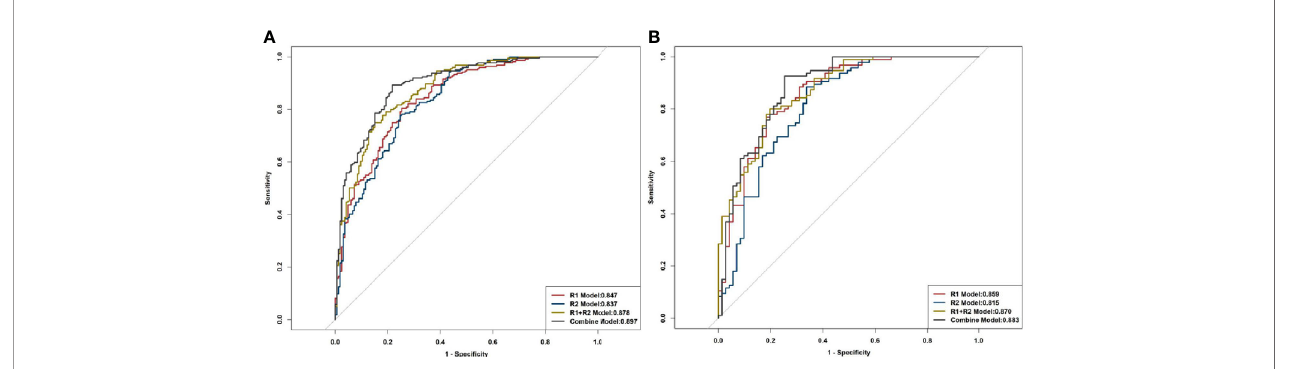
FIGURE 5 | ROC curves of R1, R2, R1+R2, and the combined model for distinguishing LNM. (A) Training cohort. (B) Validation cohort.